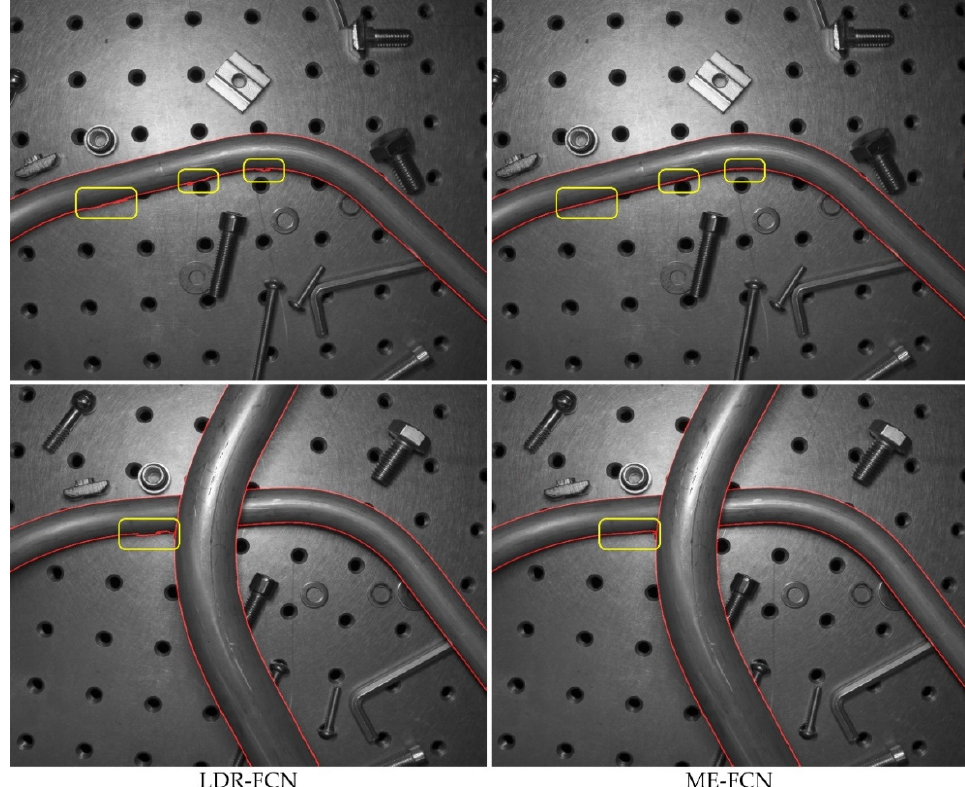
Figure 9. Tube contour detection results on several samples. The images in the left column were produced by an FCN model that took the LDR image as input, and in the right column were produced by an FCN model that took ME images as input.